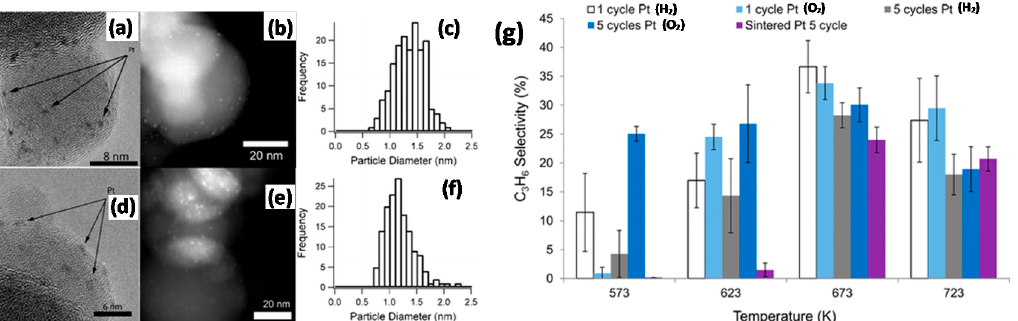
Figure 14. High-resolution TEM, HAADF-STEM and corresponding particle size distributions of Pt/Al 2 O 3 catalysts prepared via ( a )–( c ) one Pt ALD cycle with O 2 , and ( e )–( f ) one Pt ALD cycle with H 2 . Arrows indicate Pt NPs. ( g ) Propylene selectivities as a function of temperature in the PODH reaction for Pt/Al 2 O 3 catalysts prepared via Pt-H 2 /O 2 ALD with a variable number of cycles. “Sintered Pt 5 cycles” denotes an ALD catalyst prepared using 5 Pt ALD cycles (O 2 ) which was intentionally sintered to 1.6 nm (by treating in 100% H 2 for 4 h at 600 °C). Reaction conditions: 12 sccm C 3 H 8 , 6 sccm O 2 , 182 sccm Ar, m cat = 100 mg. Adapted with permission from Ref. [234]. Copyright 2015 American Chemical Society.